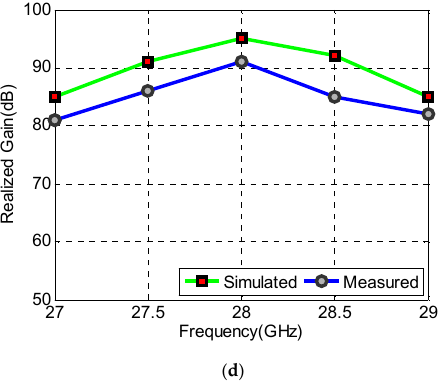
Figure 14. Simulated and measured curves: ( a ) Peak Gains at sub-6 GHz bands, ( b ) peak Gains at mm-wave band, ( c ) % η at sub-6 GHz bands, ( d ) % η at mm-wave band.